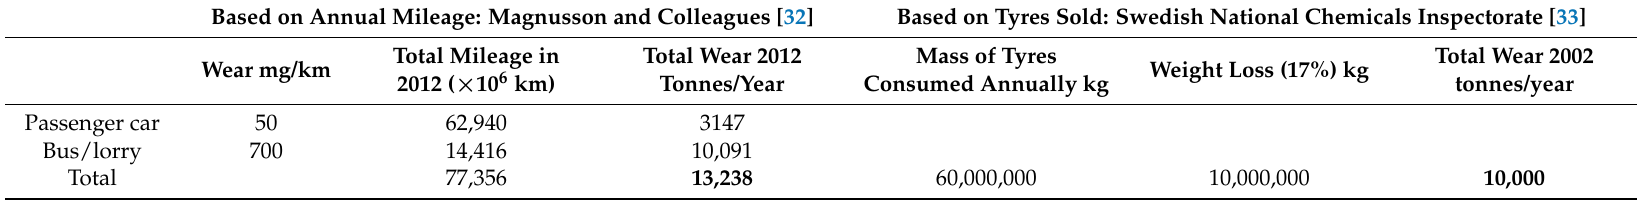
Table 3. Calculation of the amount of tyre wear and tear in Sweden [32,33]. Based on Annual Mileage: Magnusson and Colleagues [32] Based on Tyres Sold: Swedish National Chemicals Inspectorate